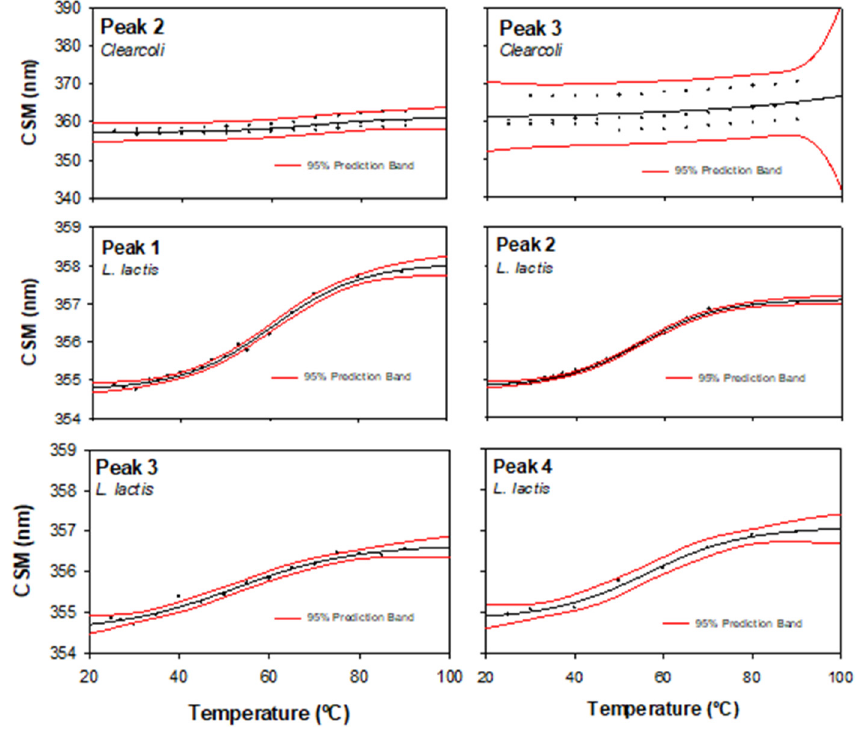
Figure 4. Center of spectral mass of the tryptophan fluorescence spectrum (CSM) versus temperature of each MMP-9 peak (indicated in the plot). The solid line indicated the nonlinear regression to a sigmoidal model; red lines indicated 95% of the prediction interval.